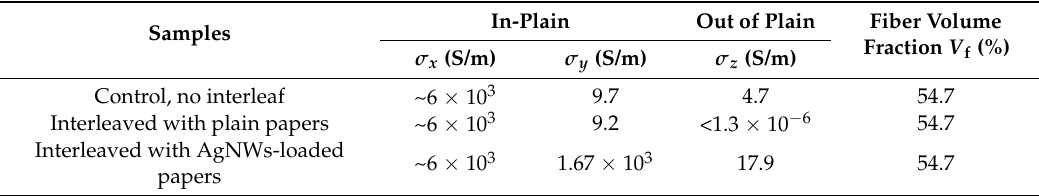
Table 1. Electrical conductivity of composite laminates samples